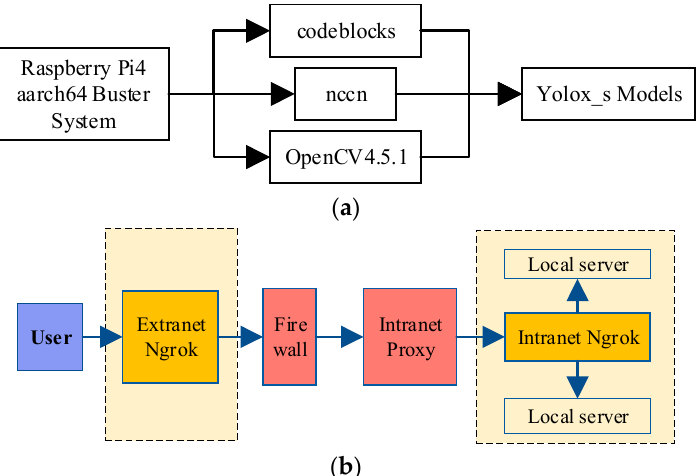
Figure 7. Platform Raspberry Pi platform build. ( a ) Implementation flow of embedding YOLOX_s in Raspberry Pi system. ( b ) Raspberry Pi and Web platform interconnection channel.